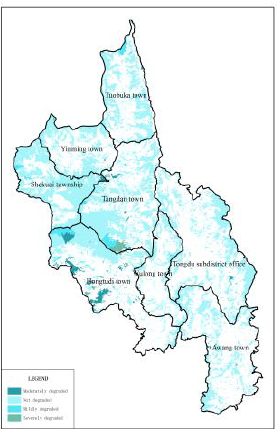
Figure 3. Grassland degradation distribution map of Dongchuan County